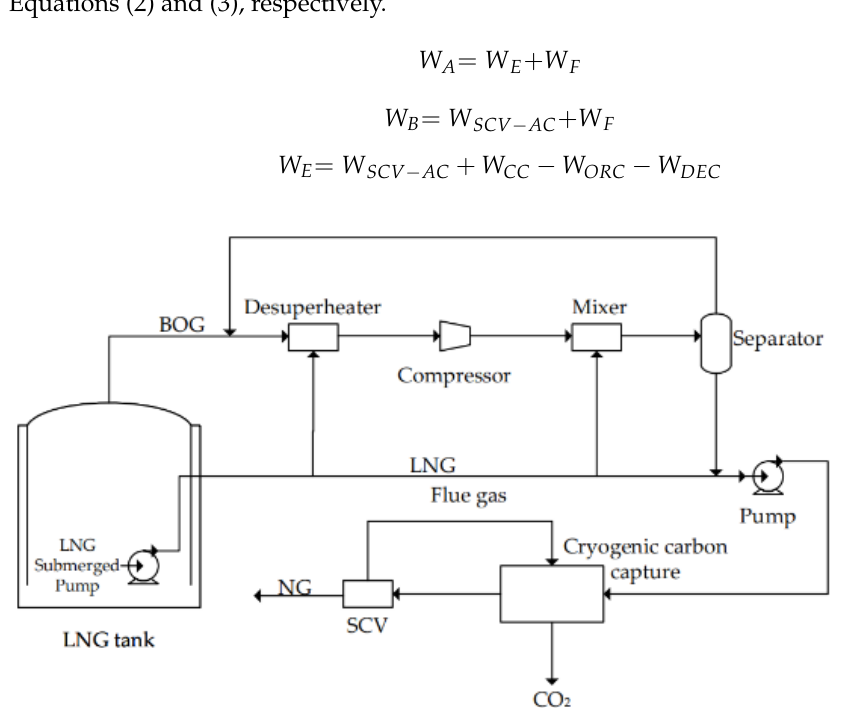
Figure 3. Low carbon operation strategy of the LNG receiving terminal.